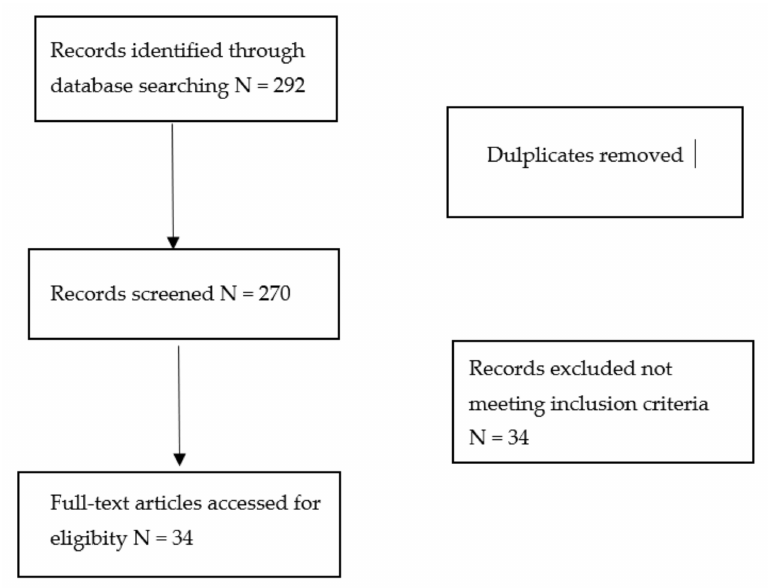
Figure 3. Literature search and article selection according to PRISMA